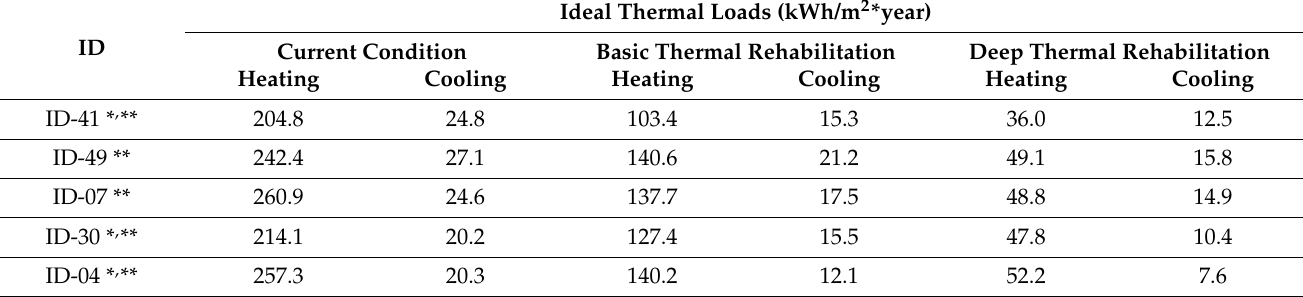
Table 9. Ideal annual thermal loads.